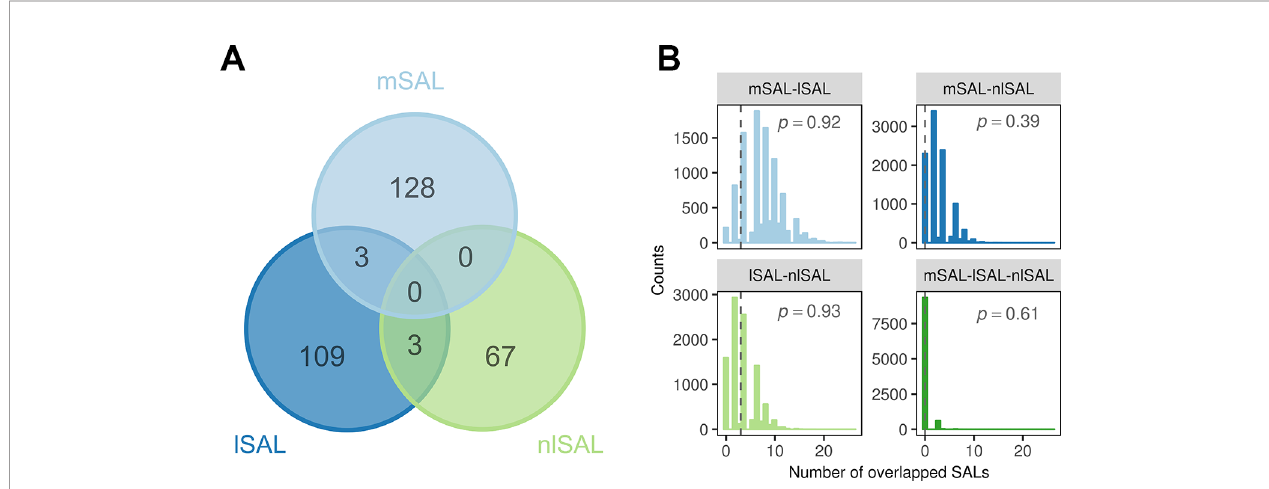
FIGURE 3 | The overlap between three types of SALs for the same element. (A) Venn plot of overlap between the mSALs, lSALs, and nlSALs. (B) The null- distribution of overlap between different types of SALs estimated from 10,000 permutations. The vertical lines denote the number of overlaps between the three types of SALs identi fi ed in this study. The P values of the overlaps calculated in this study are labeled in each